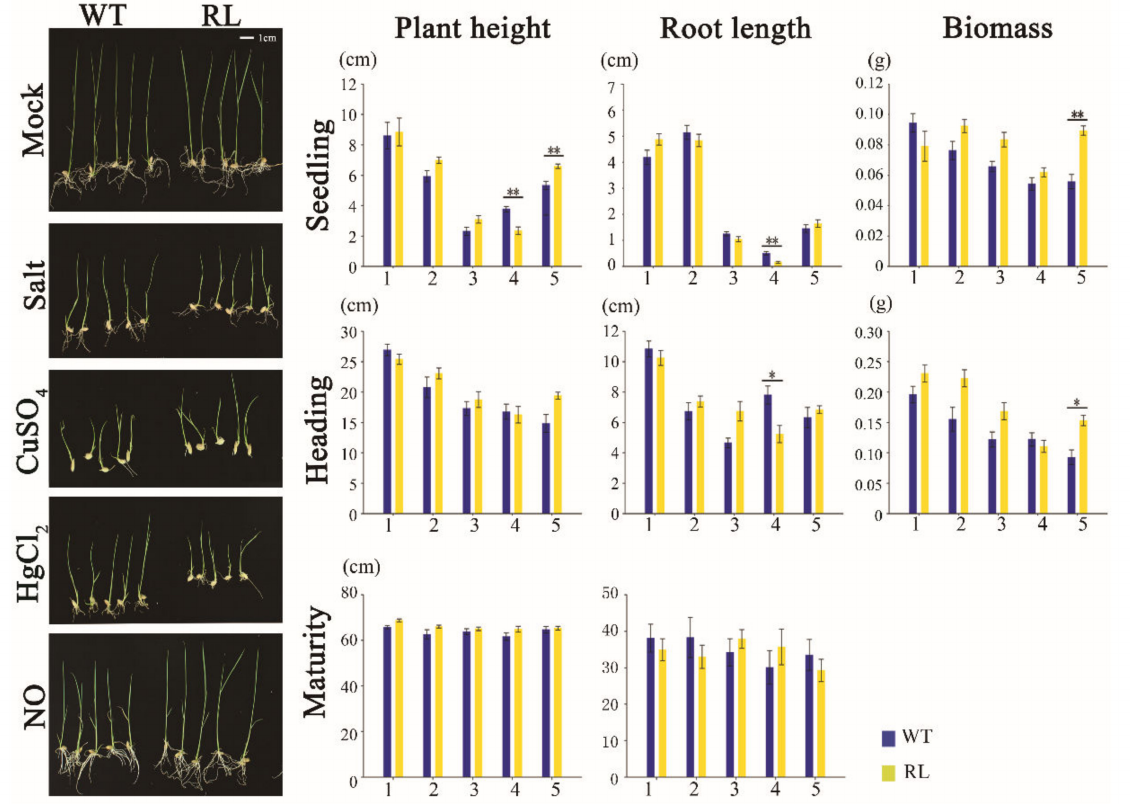
Figure 5. Phenotypic variation following between RL and its donor WT following different abiotic stress. Plant height, root length, and biomass were determined at seedling stage, heading stage, and maturity stage in WT and RL, respectively. * C p < 0.05, ** C p <